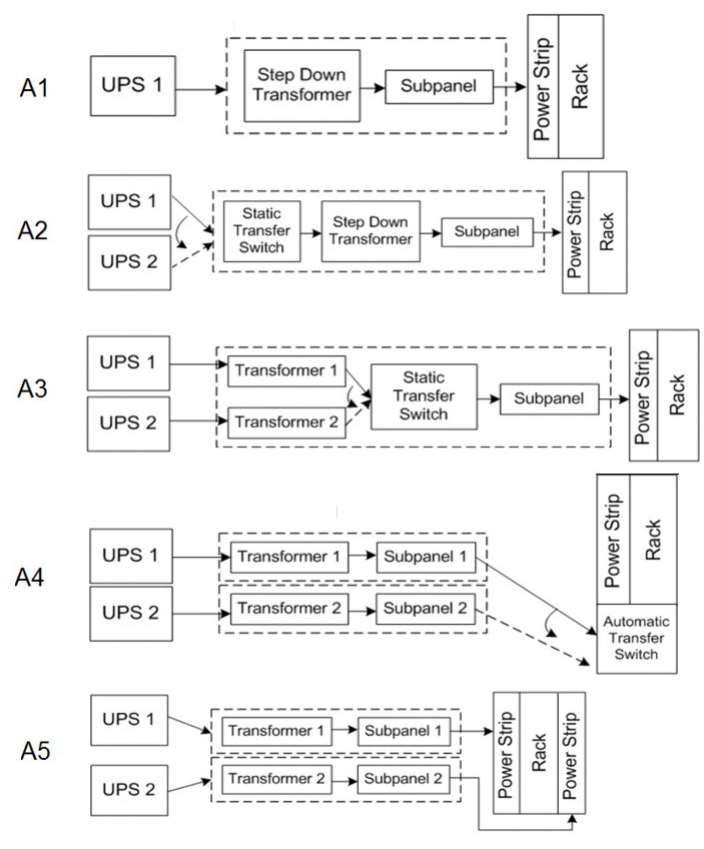
Figure 12. Data center power